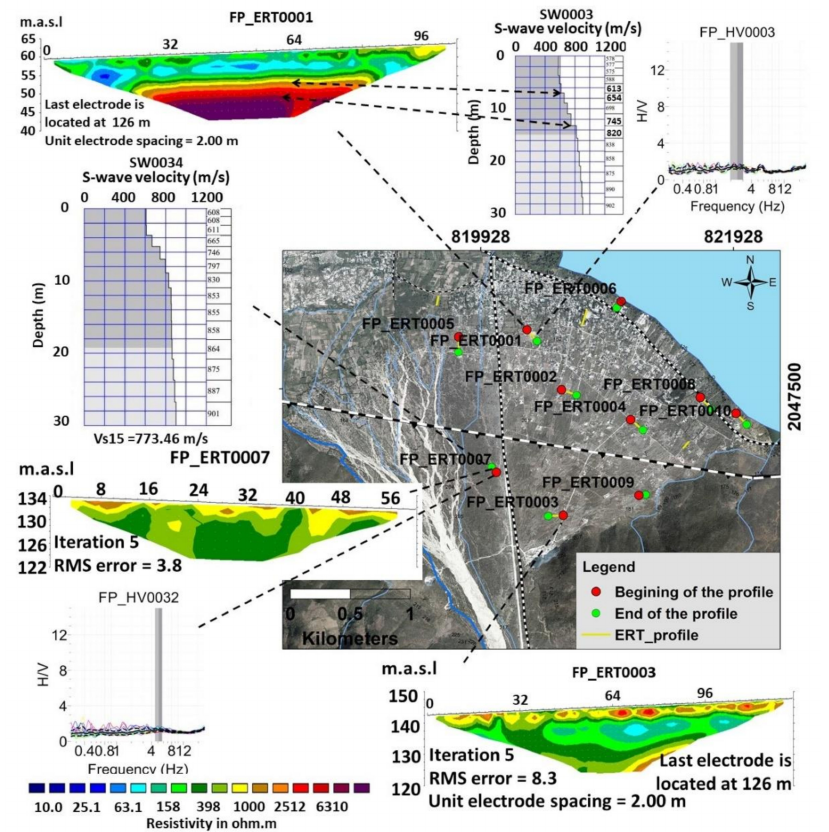
Figure 13. Comparison between ERT and MASW results for measurements completed on the central and upper parts of the alluvial